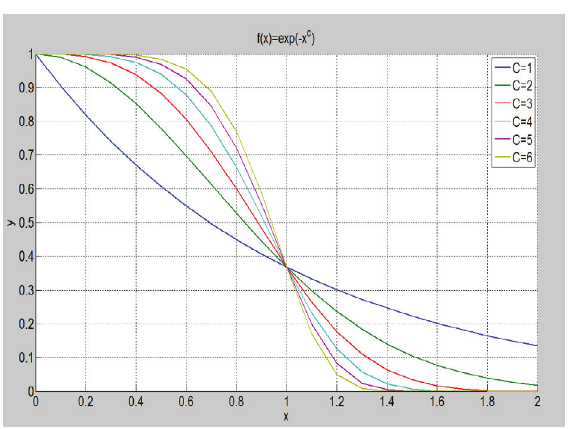
Fig.1. Graph of the function C x exf (cid:16) (cid:32) )( From Fig.1, we know that the top and bottom of the graph are smooth, but the graph changes rapidly near 1 (cid:32) x . With the increased value of constant C, the steepness of the graph increases. With the feature of the P and function, the values of the crossover operator c P can be expressed as follows mutation operator m